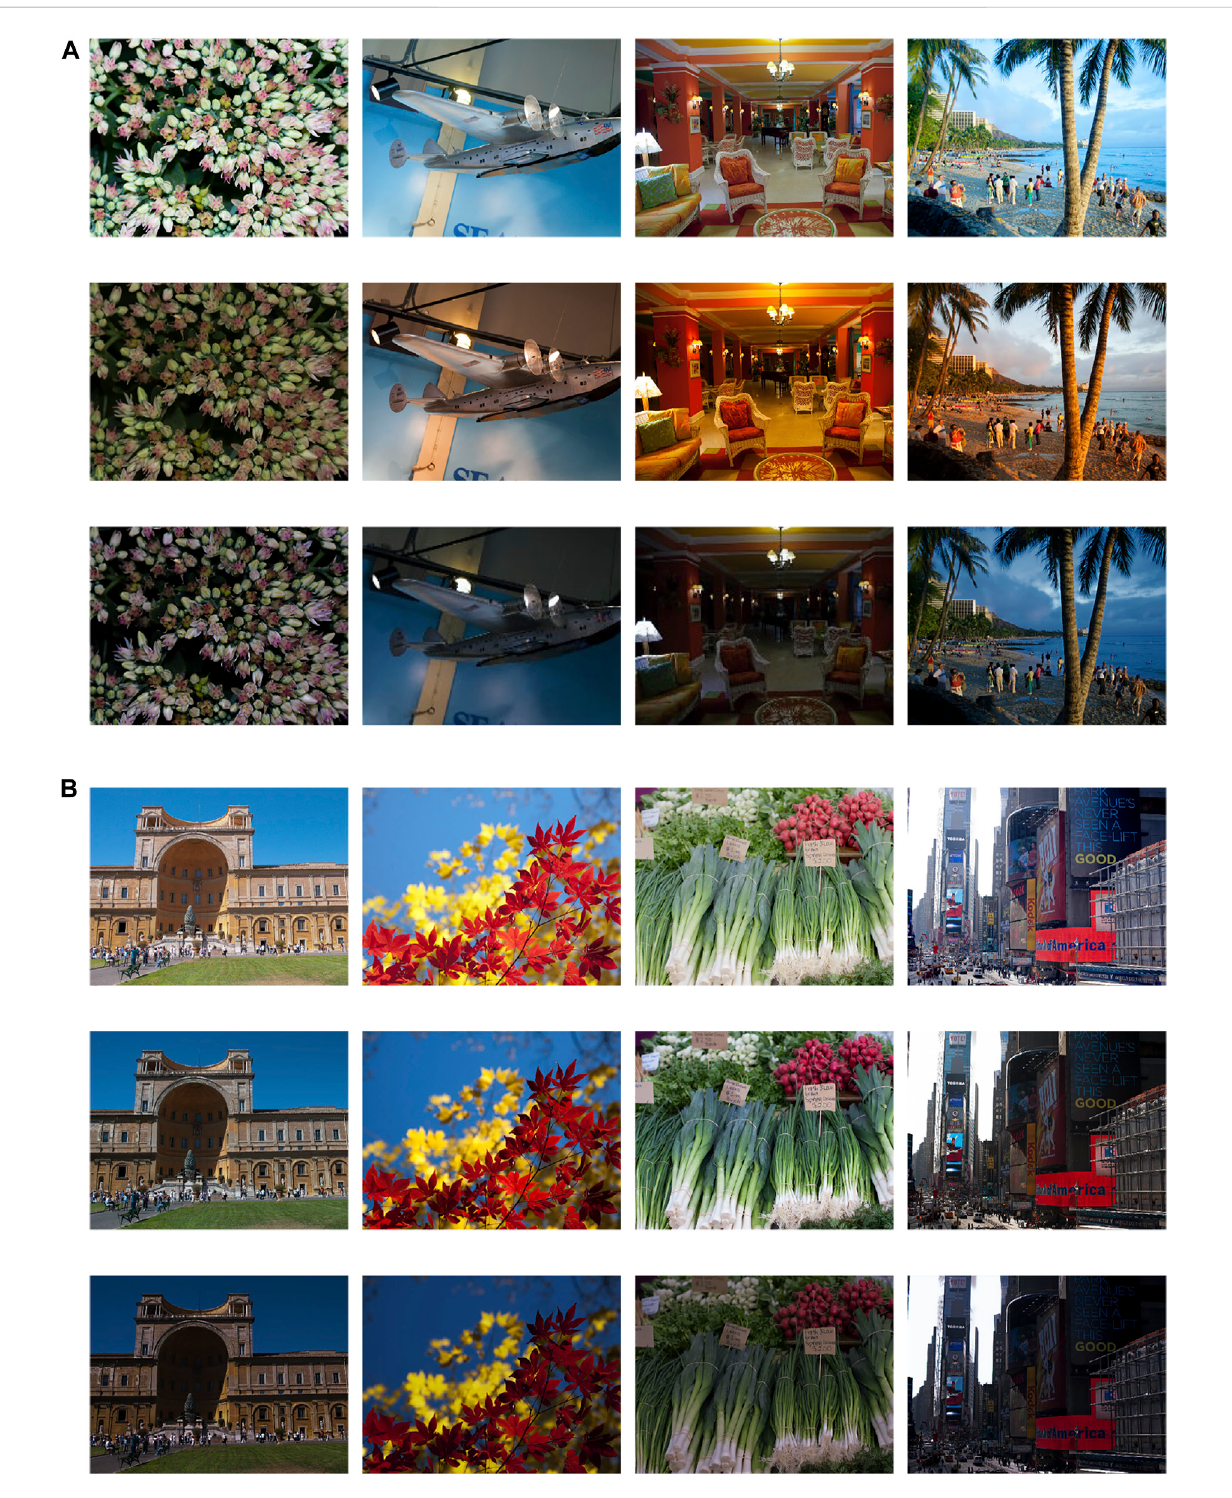
FIGURE 4 ThecomparisonofLLimagesfromtheexistingdatasetandpseudo-LLonessynthesizedbyourmethod. (A) ThecomparisonofwhitebalanceofLL- images; (B) The comparison of illumination level. The 1st, 2nd, and 3rd in both (A) and (B) show original normal-light images, LL images from the existing dataset, and pseudo-LL ones generated by our method, respectively. The images in the 3rd row of each panel are in line with the distribution of the real world in terms of illumination level and white